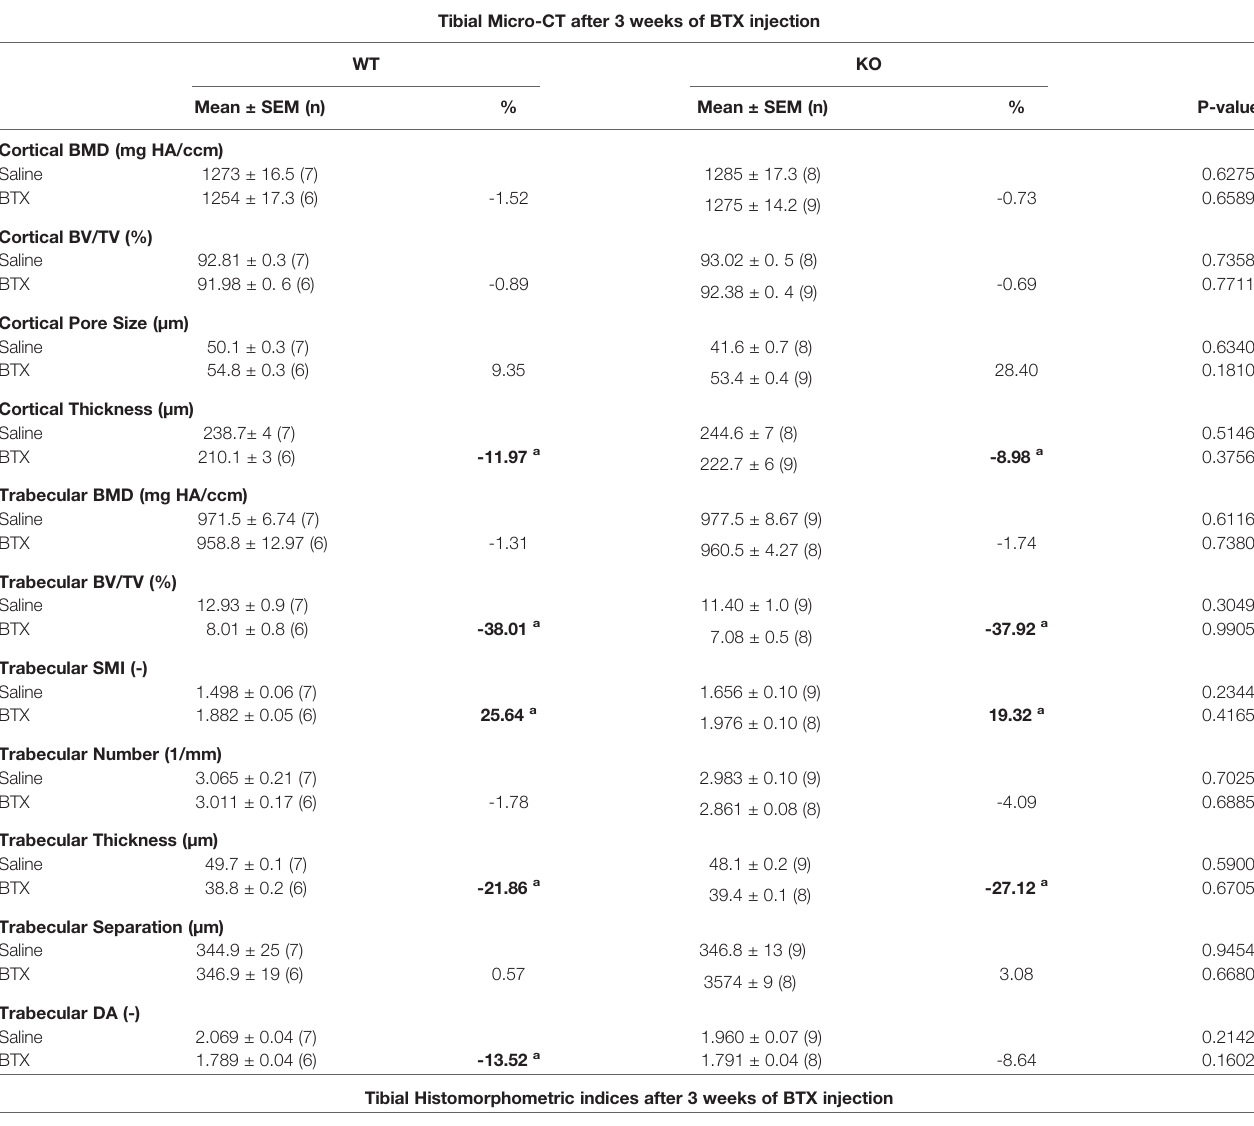
TABLE 3 | Quantitative data of tibial micro-CT and histomorphometric indices in WT and KO mice injected with saline or